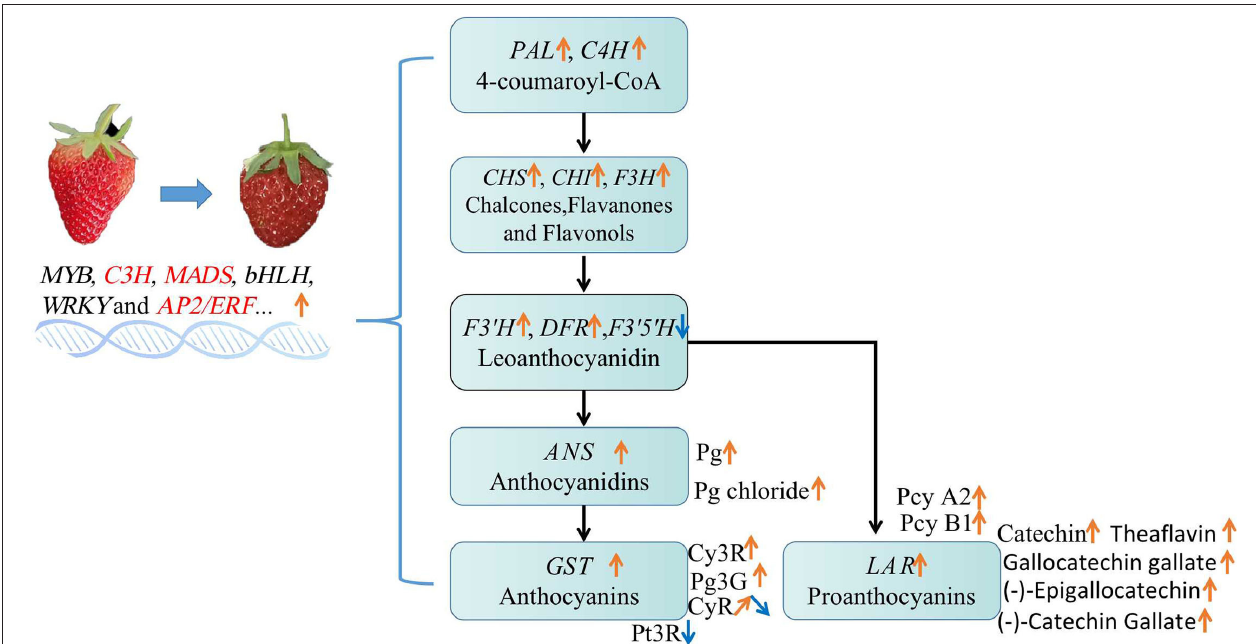
FIGURE 10 | The alteration of flavonoid compounds in MT comparing with WT fruits. Changes of the gene expression and metabolites involved in flavonoid biosynthesis pathway were listed. Pg, pelargonidin; Cy3R, cyanidin 3- O -rutinoside; Pg3G, pelargonidin 3-glucoside; Pt3R, petunidin 3- O -rutinoside; CyR, cyanidin O -rutinoside; Pcy, procyanidin. Orange arrows represented up-regulation, blue arrows indicated down-regulation.